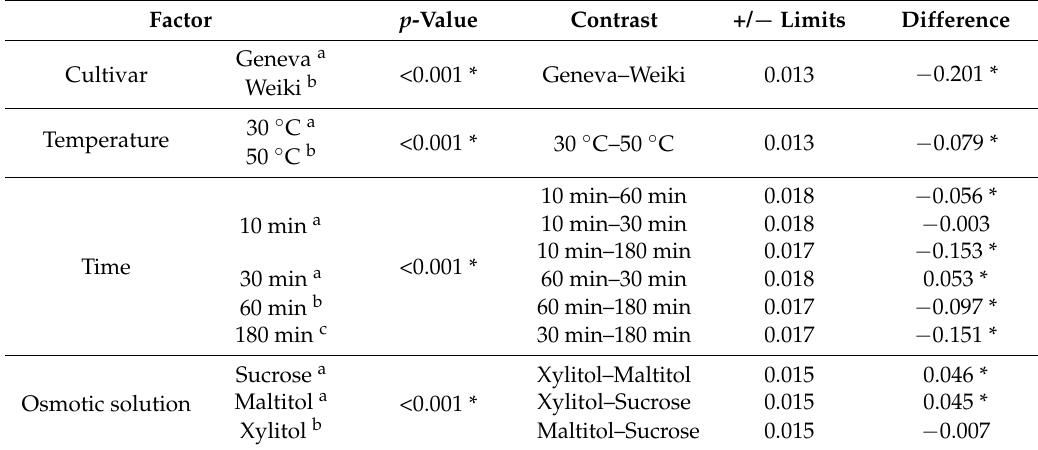
Osmotic solution